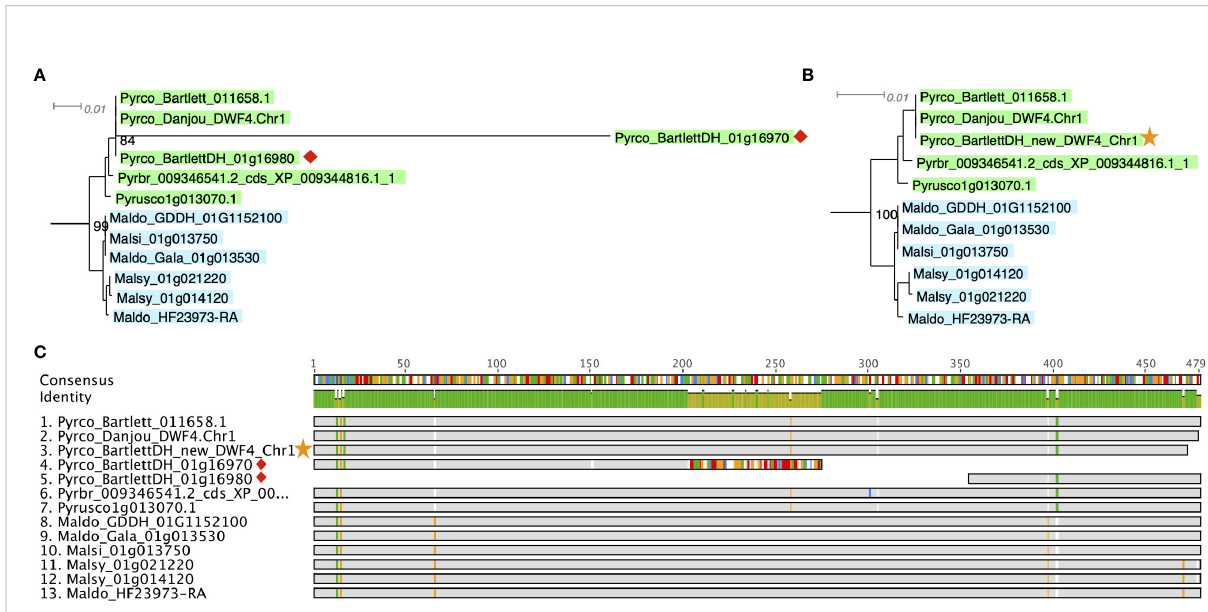
FIGURE 8 Example of a putative DWF4 gene before (red diamond) and after (yellow star) improvement. (A, B) show a section of the DWF4 gene family tree with Bartlett_DH gene models before and after improvement, respectively. (C) is the sequence alignment of the DWF4 gene coding region in Malus and Pyrus genomes. Gray color indicates identical nucleotides compared to the consensus, while colors indicate different nucleotides. Genome abbreviations can be found in Supplemental Table